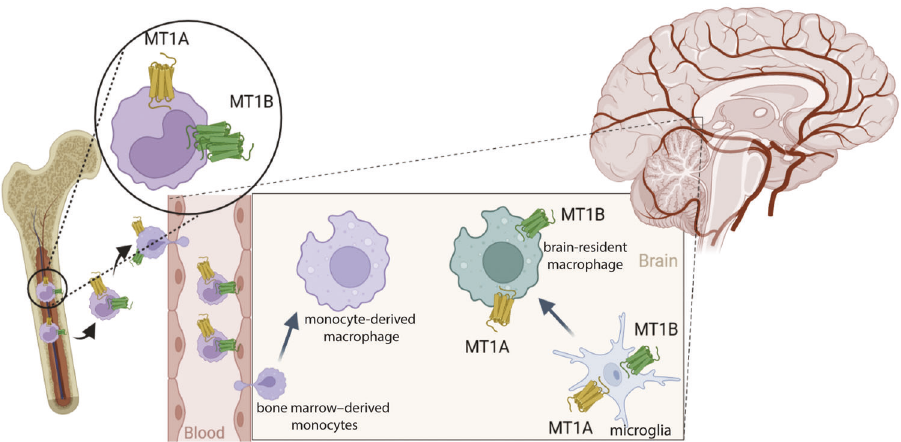
Fig. 8 Schematic illustration of melatonin receptor (MT1A and MT1B) expression by monocytes/macrophages. Monocytes express melatonin receptors in the BM and the circulation. However, monocytes lose this expression after in fi ltrating the CNS and differentiating into macrophages. On the other hand, microglia, and brain-resident macrophages express melatonin receptors, while BM-derived macrophages lack this expression in demyelinated